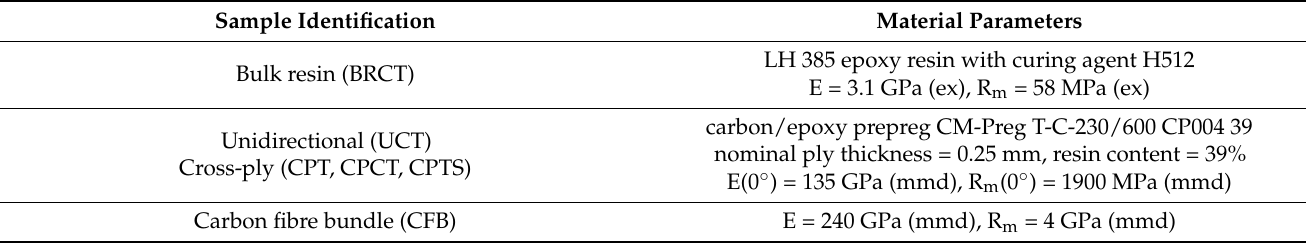
Table 3. Characterisation of the test specimens.